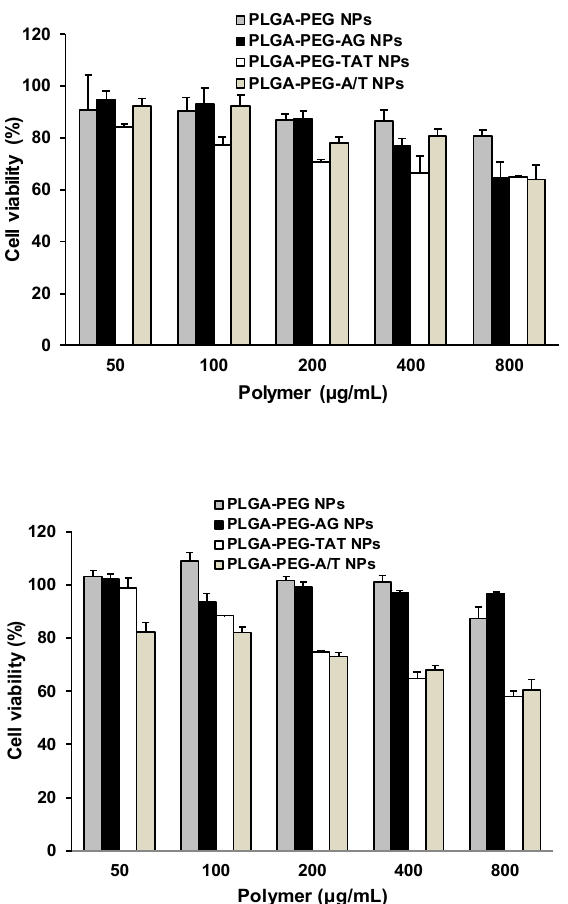
Figure 6. Cell viability of PLGA-PEG NPs, PLGA-PEG-AG NPs, PLGA-PEG-TAT NPs, and PLGA- Cell viability of PLGA-PEG NPs, PLGA-PEG-AG NPs, PLGA-PEG-TAT NPs, and PEG-A/T NPs in ( A ) CD133(+) H69 cells and ( B ) A549 cells for 72 h ( n = 3). PLGA-PEG-A / T NPs in ( A ) CD133( + ) H69 cells and ( B ) A549 cells for 72 h ( n =